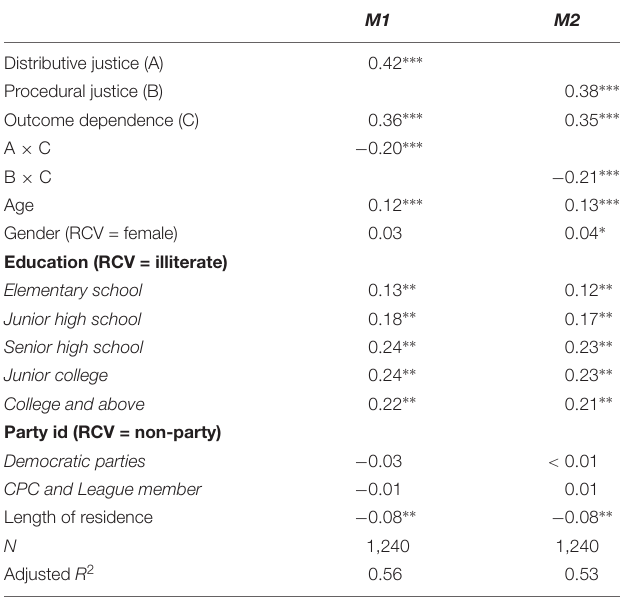
TABLE 6 | Linear regression of public cooperation intention with social justice, outcome dependence, and their